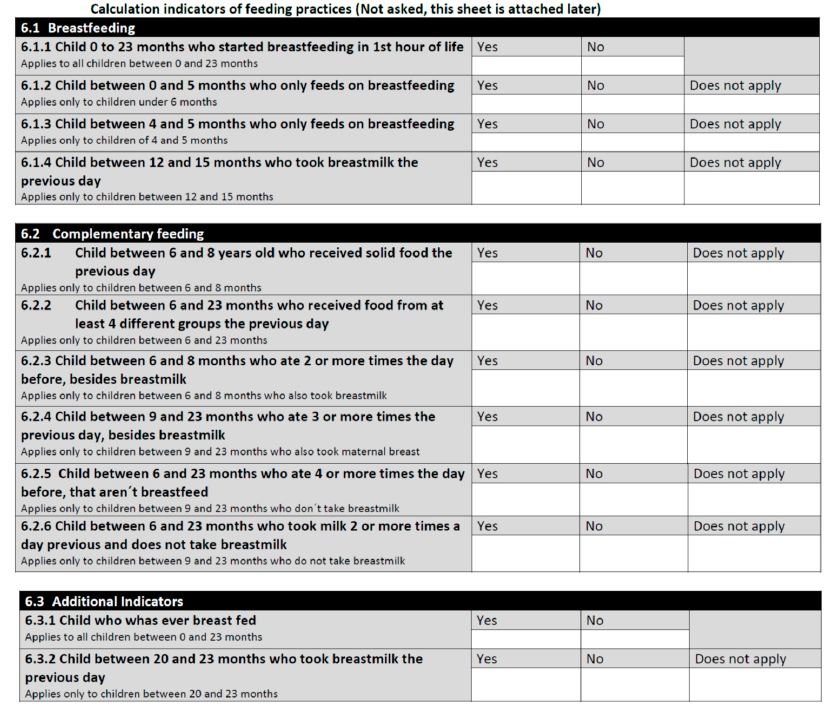
Figure A2. Calculation Indicators of Feeding Practices (Not asked, this sheet is attached later).